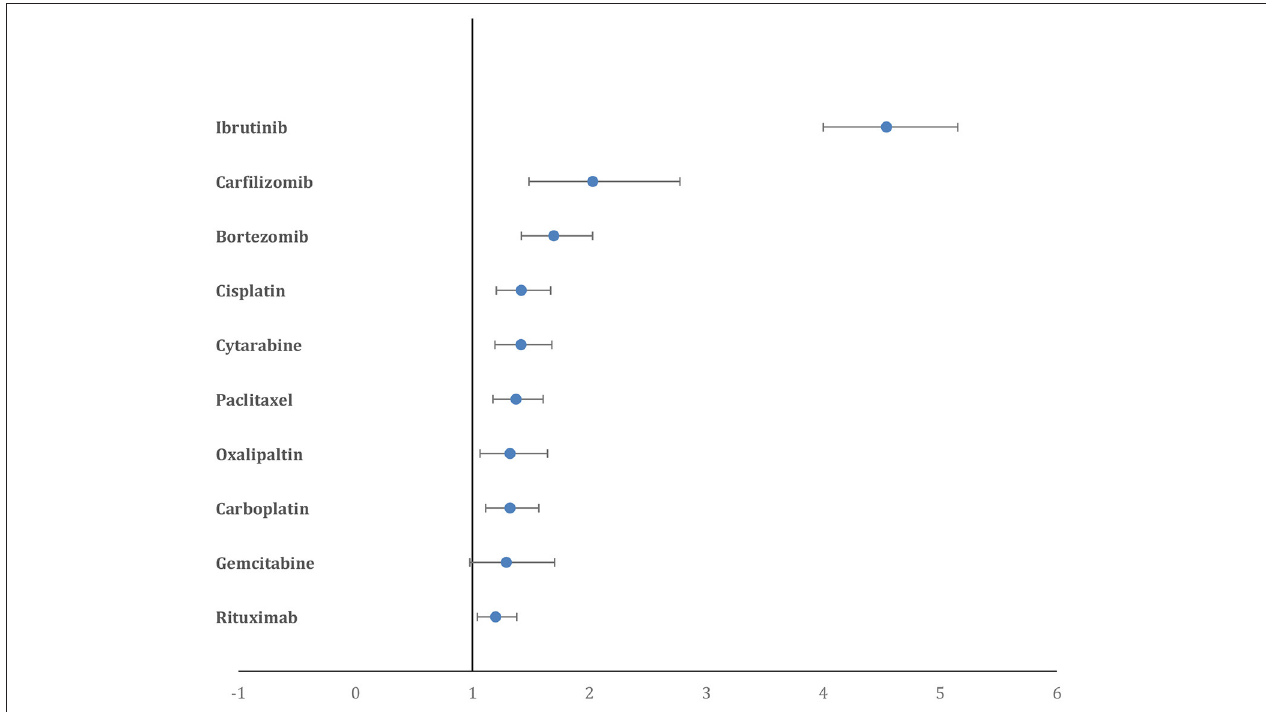
FIGURE 4 | Forest plot showing the PRR of deaths in AF cases for the top 10 drugs. Ibrutinib has a significantly higher PRR compared to all other